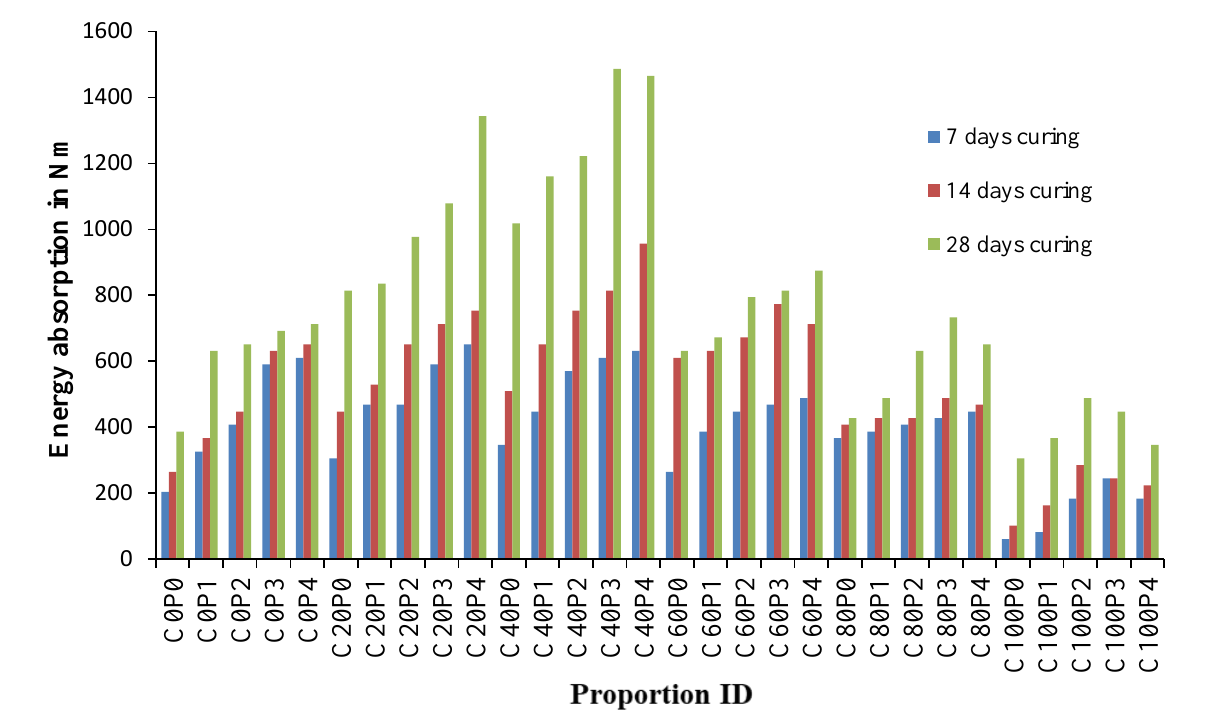
Figure 23. Energy absorption capacity.